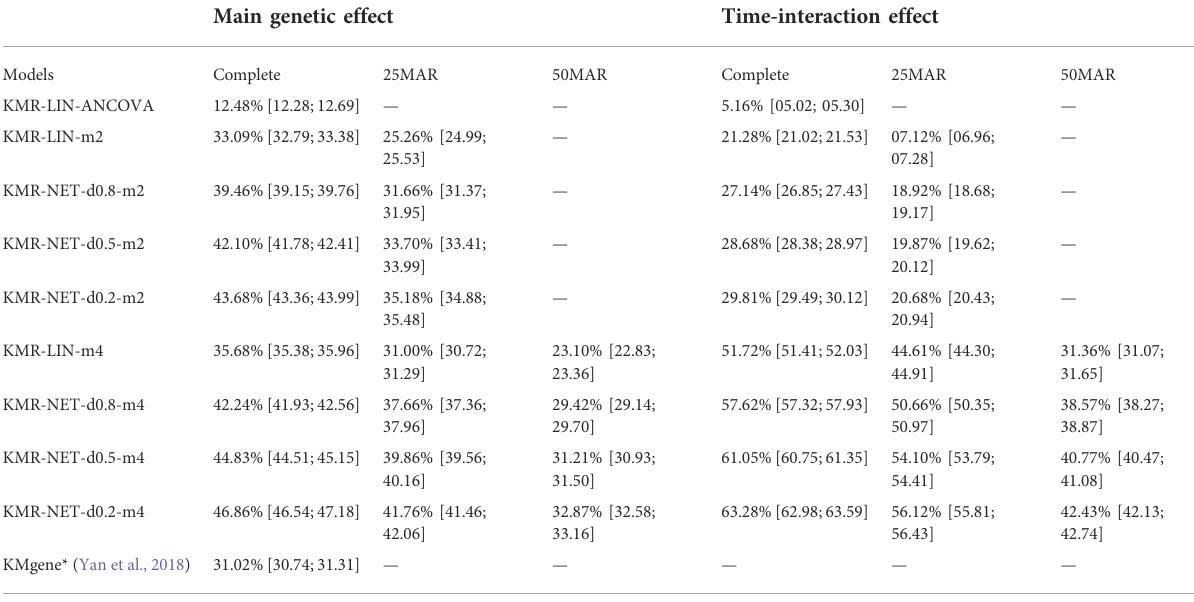
Simulated power to detect an effect of size 0.04 with a test at signi fi cance levels of α = 5% is displayed. The simulations are based on 100,000 runs each with 1,000 individuals. Power estimates together with 95% con fi dence interval are presented for genetic main and time-interaction effects. Phenotype data were either complete or with 25/50% of values missing at random (MAR). Model names correspond with Table 1. *For comparability, the single gene-level p -values of KMgene are combined to a pathway p -value using Fisher ’ s method.